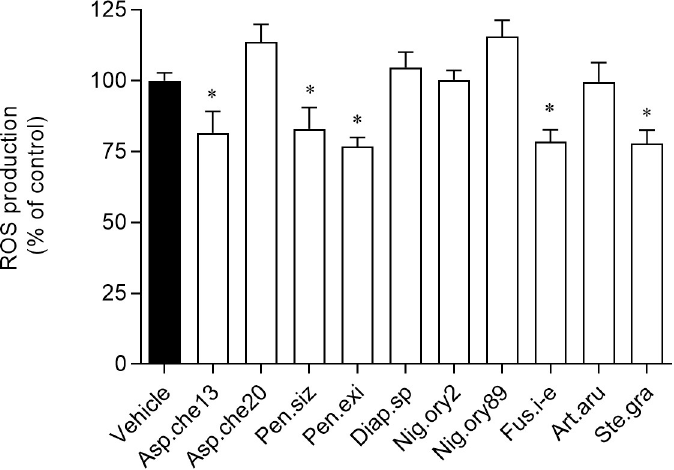
Fig 5. Reactive oxygen species (ROS) production induced on 3T3 cells after being treated with fungal extracts at 1 μ g/mL and exposed to UV radiation (12.5 mJ/cm2). The fungi from which the extracts were obtained are abbreviated as follows: Asp.che13 or 20, isolates 13 or 20 of Aspergillus chevalieri ; Pen.siz, Penicillium sizovae ; Pen.exi, Penicillium sect. Exilicaulis ; Diap.sp, Diaporthe sp.; Nig.ory2 or 89, isolates 2 or 89 of Nigrospora oryzae ; Fus.i-e, Fusarium incarnatum-equiseti complex; Art.aru, Arthrinium arundinis ; Ste.gra, Stemphylium gracilariae . The values correspond to mean ± SEM. � represents significant differences (One-way ANOVA, Dunnett’s test; p < 0.05) when compared with the